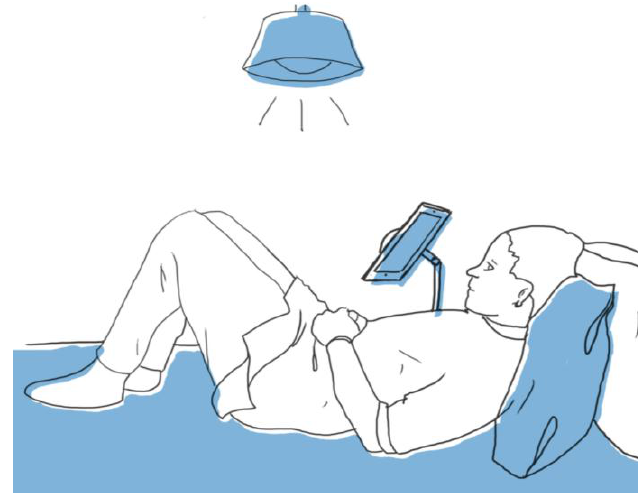
Figure 1. Tipped position with iPad